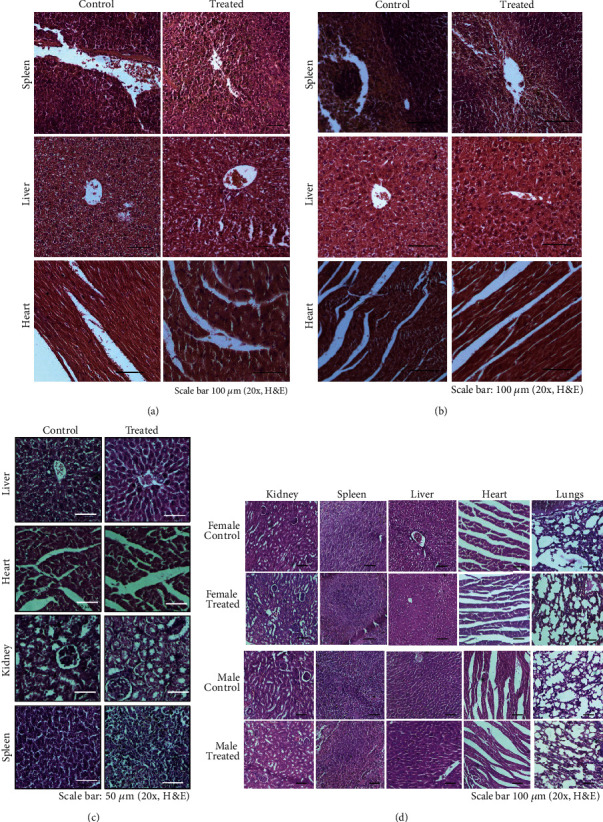
Histopathology of different organs from mice of acute, subchronic, and chronic toxicity studies. (a) Organs from control and 5000 mg/kg MEFM2-fed mice were isolated. These are sectioned and stained with Haemotoxylin and Eosin (H&E) for histopathological observation as discussed in Methods. (b) Histopathology of different organs collected from 14-day-fed mice. (c) Histopathology of different organs collected from 90-day-fed mice (sub-chronic toxicity study). (d) 180-day-fed mice (chronic toxicity study) were similarly stained for histopathology study. No significant changes or damages were observed in tissues of MEFM2-fed mice compared to the control groups. All are representative images from a single mouse from each group. Magnification (20x) and scale bar are shown in all the images.